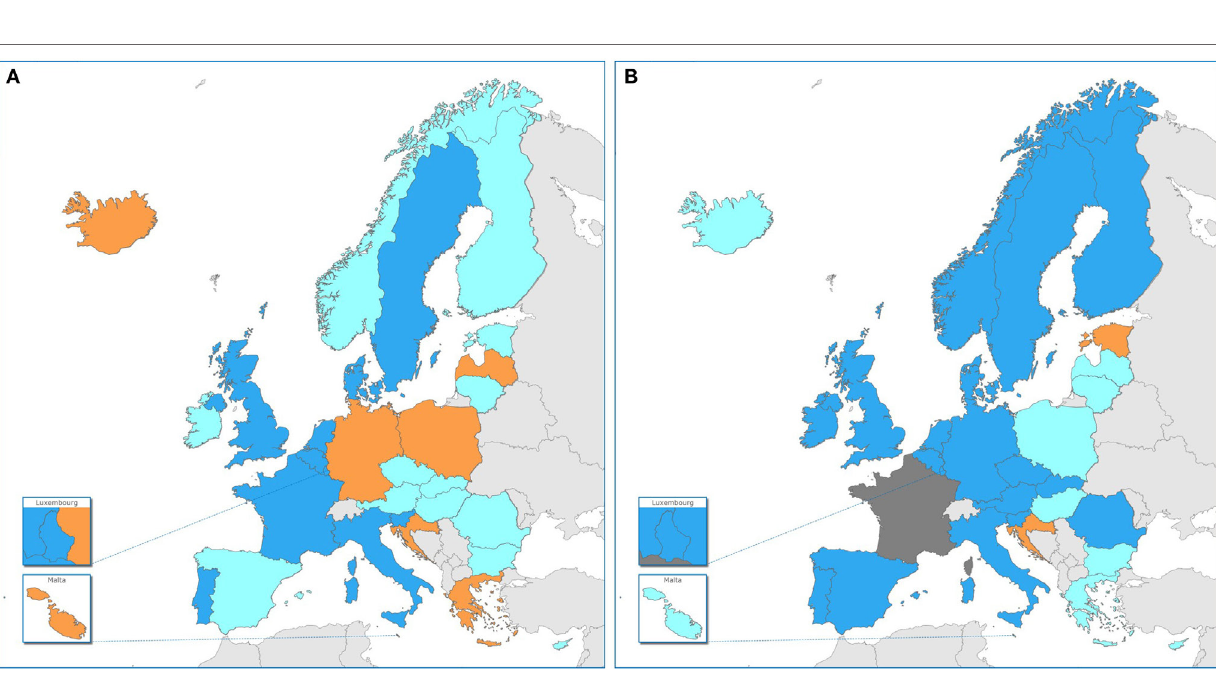
FigUre 1 | Number of EU/EEA countries with capability to use whole-genome sequencing (WGS)-based typing (dark tone) or planning to use it by 2018 (light tone) as of mid-2015 (orange bars) and mid-2016 (blue bars) applied to outbreak investigations (a) or surveillance (b) , by disease group and